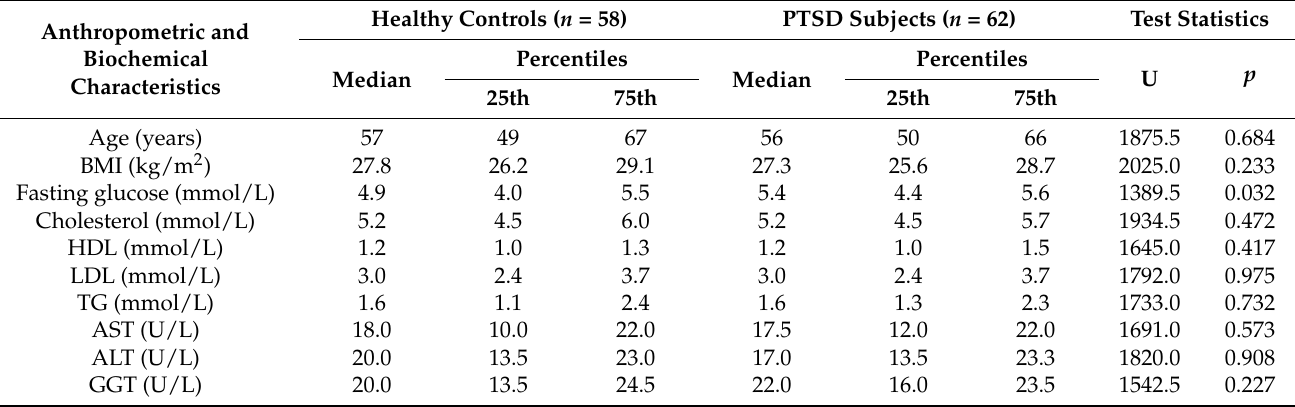
Table 1. Anthropometric and biochemical characteristics of healthy controls and patients with PTSD. Data were analyzed with Mann-Whitney U test and shown as median and 25th (Q1) and 75th (Q3) percentiles. Anthropometric and